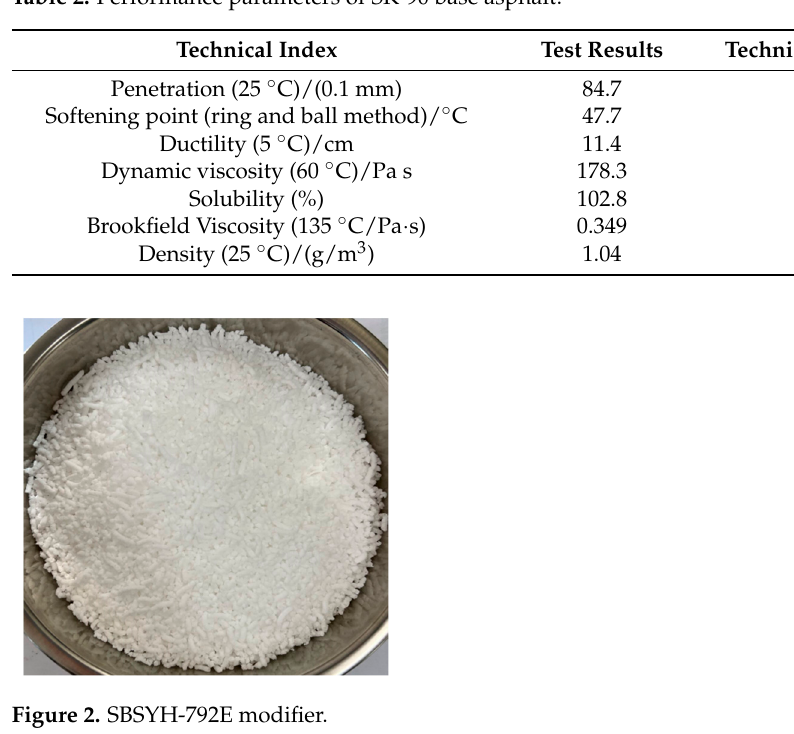
Table 2. Performance parameters of SK-90 base asphalt.